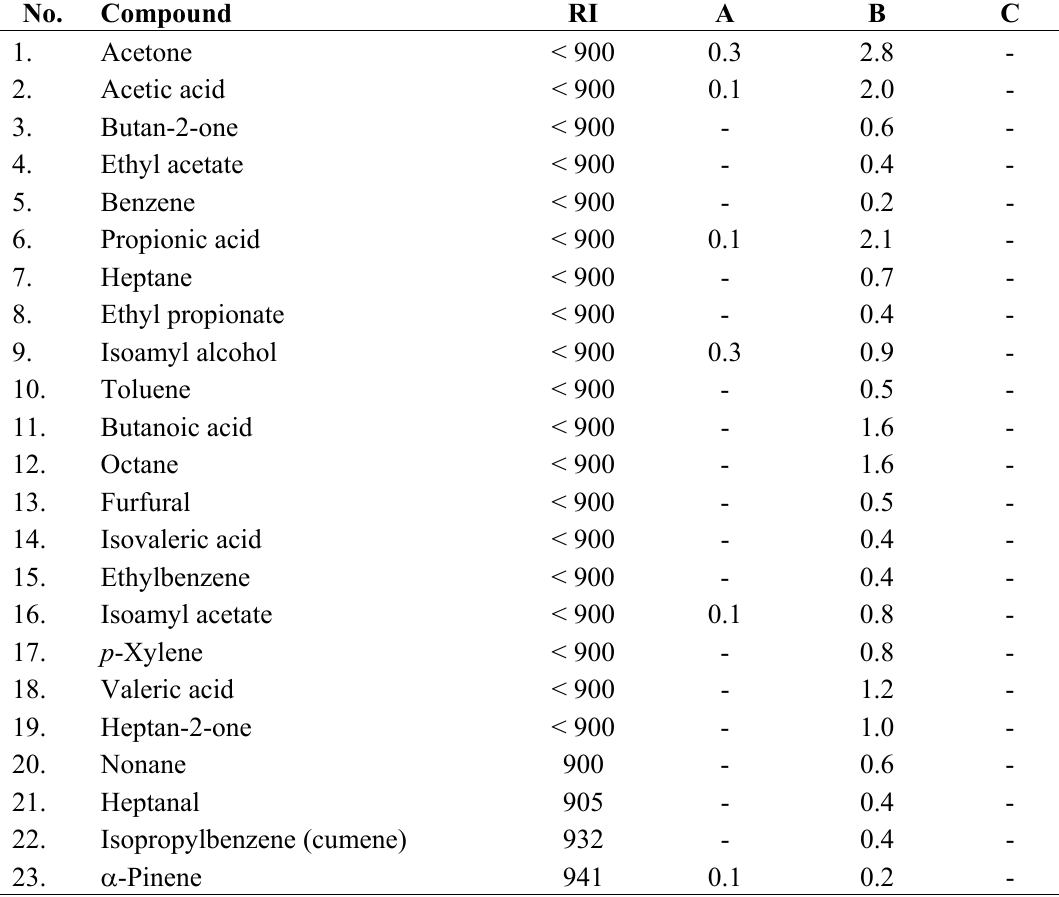
Table 1. The organic residue VOC composition obtained by HS-SPME and from the residue CH Cl solution after direct GC and GC-MS 2 2